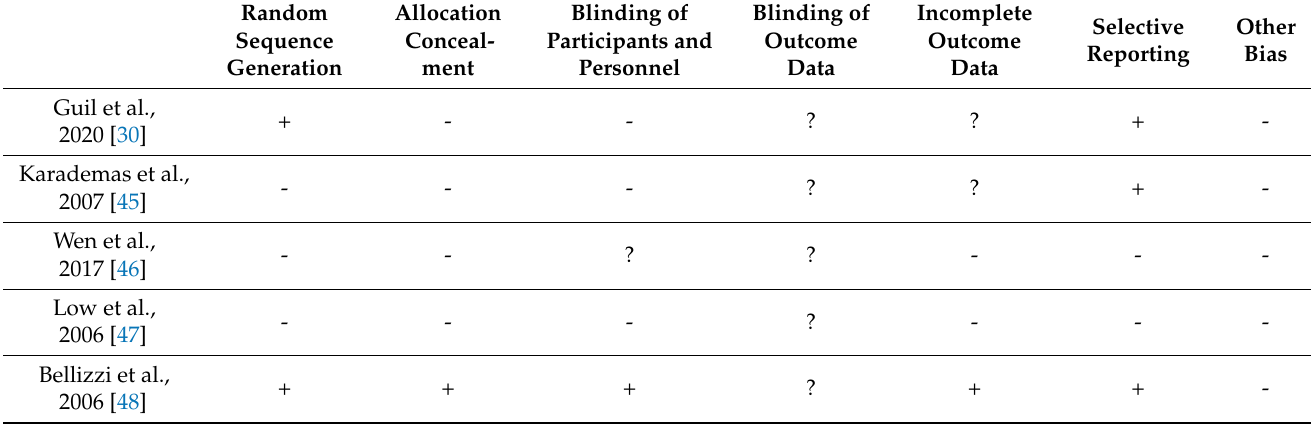
Table 1. Risk-of-bias analysis of the selected